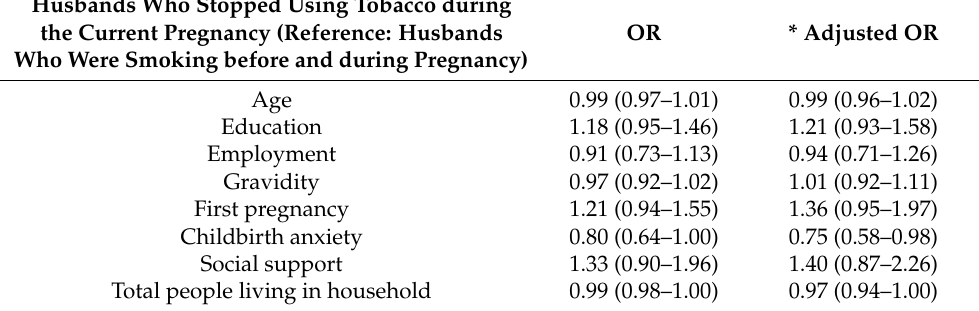
Table 4. Crude and multivariate regression model results on the associations between socio- demographic and pregnancy-related factors and self-reported husband tobacco cessation amongst pregnant women in Al Ain, UAE. The Mutaba’ah Study. Husbands Who Stopped Using Tobacco